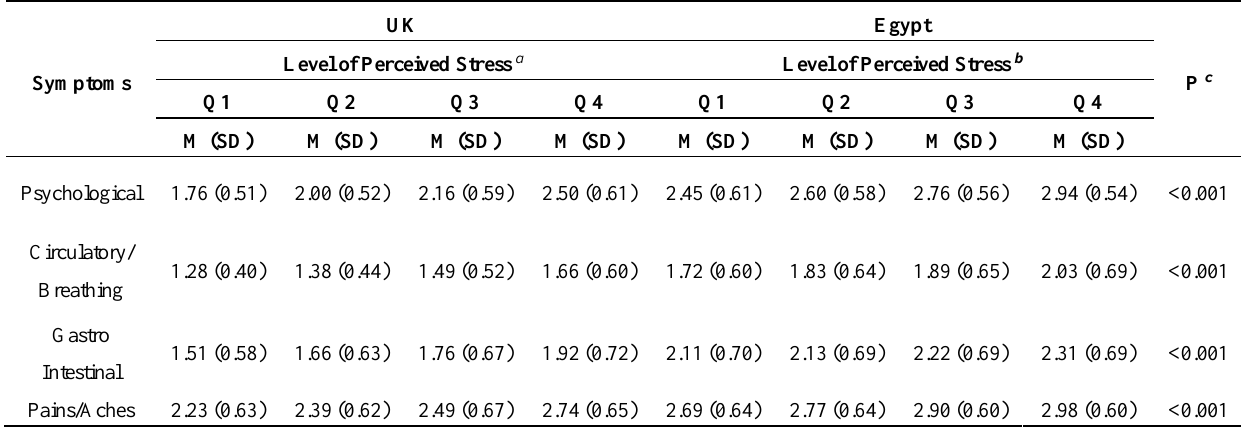
Table 5. Frequency of symptoms by level of perceived stress for UK and